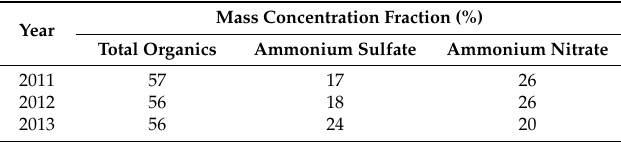
Table 2. Mass concentration fraction from ACSM measurements at SGP.